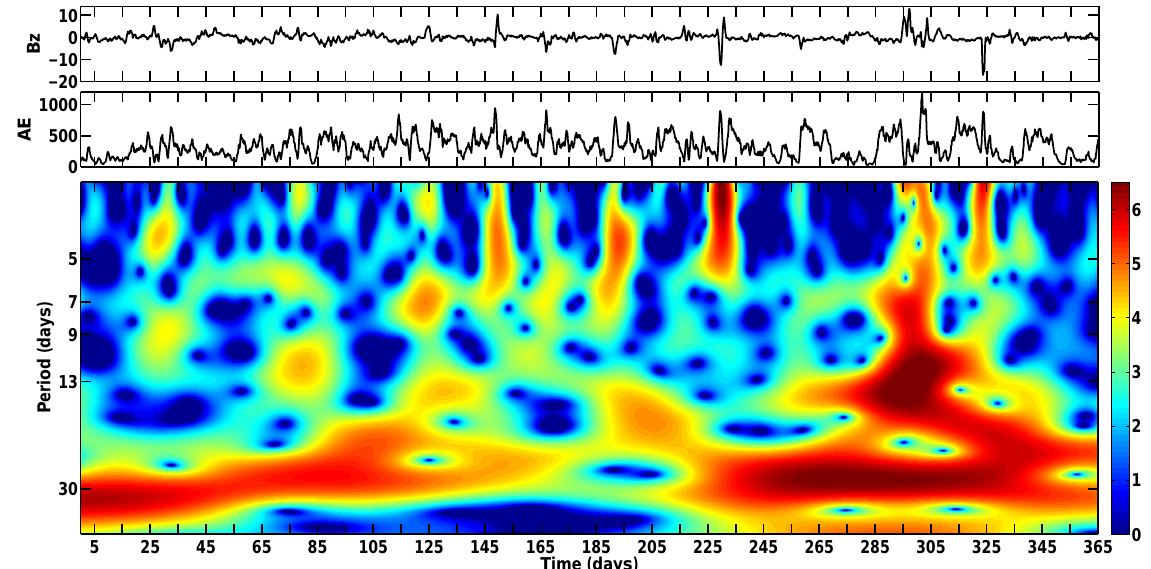
Figure 2. Morlet wavelet coherency scalogram between B z component of IMF and the AE hourly index.